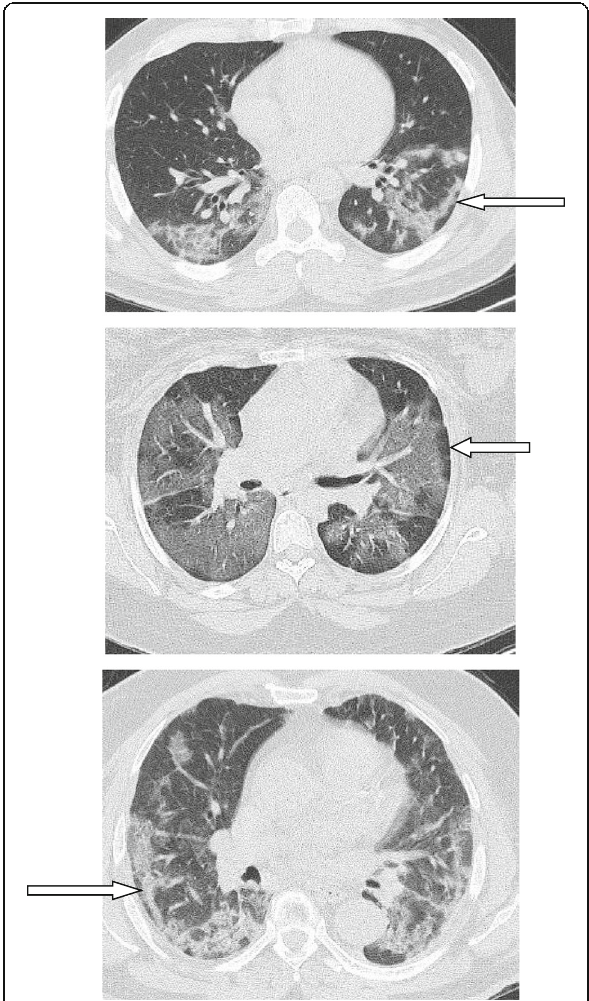
Fig. 18 Subpleural transparent line in three different patients with COVID-19